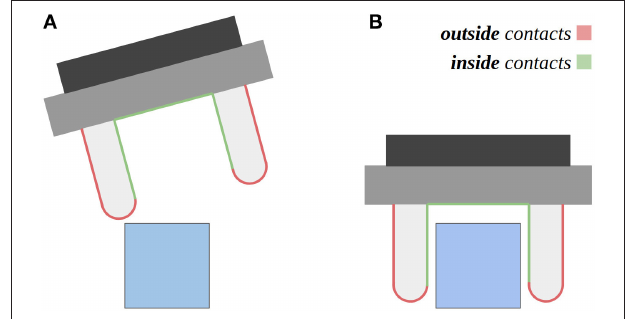
FIGURE 1 | The figure depicts two distinct moments, during the execution of a manipulation task. Two distinct areas of contact are highlighted in the robot gripper: outside contacts and inside contacts in the grasp closure. (A) Outside contacts can be used to probe the object to be grasped, or to steer the gripper pose. (B) Inside contacts can be used to know when the object is within the grasp closure, and when the gripper should stop being